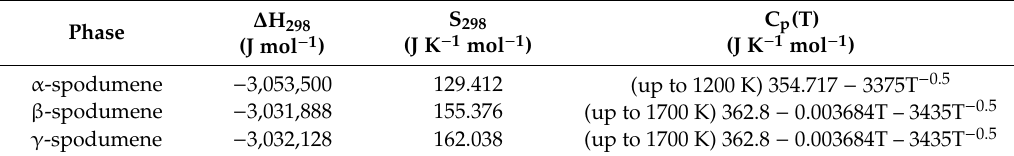
Table 6. Robie and Fasshauer’s data for α -spodumene, β -spodumene, and γ -spodumene